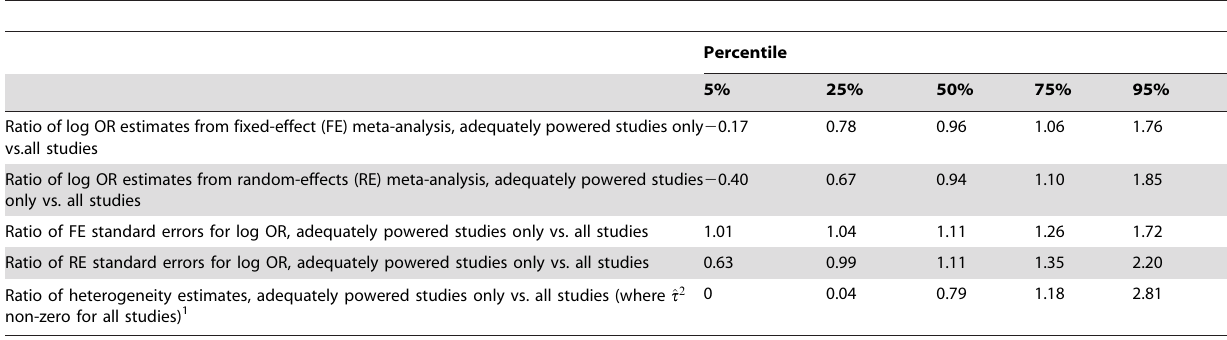
Table 4. Ratios comparing results obtained from adequately powered studies only with results obtained from all studies, in subset A of 1,107 meta-analyses: results shown are percentiles of the distribution of such ratios across meta-analyses.